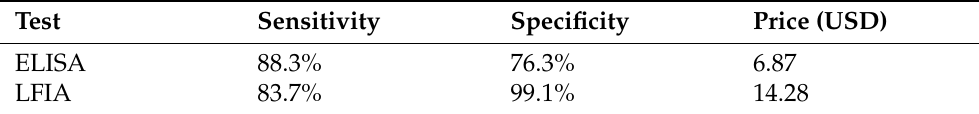
Table 1. Median values of the data found in de Assis et al.